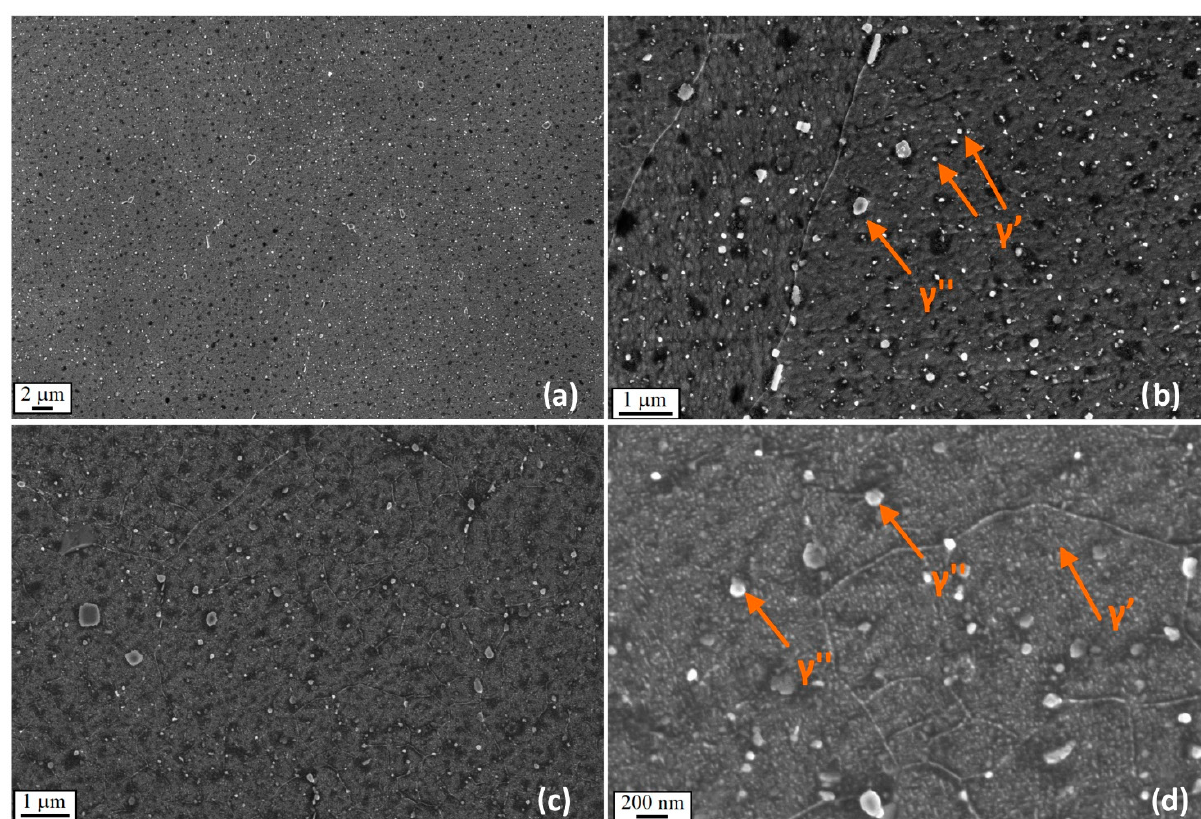
Figure 8. Microstructure after solution annealing at 1065 °C for 2 h and subsequent aging at 650 °C for 8 h at low ( a ) and high ( b ) magnification. Microstructure after solution annealing at 1065 °C for 2 h and subsequent aging at 720 °C for 8 h at low ( c ) and high (d) magnification.